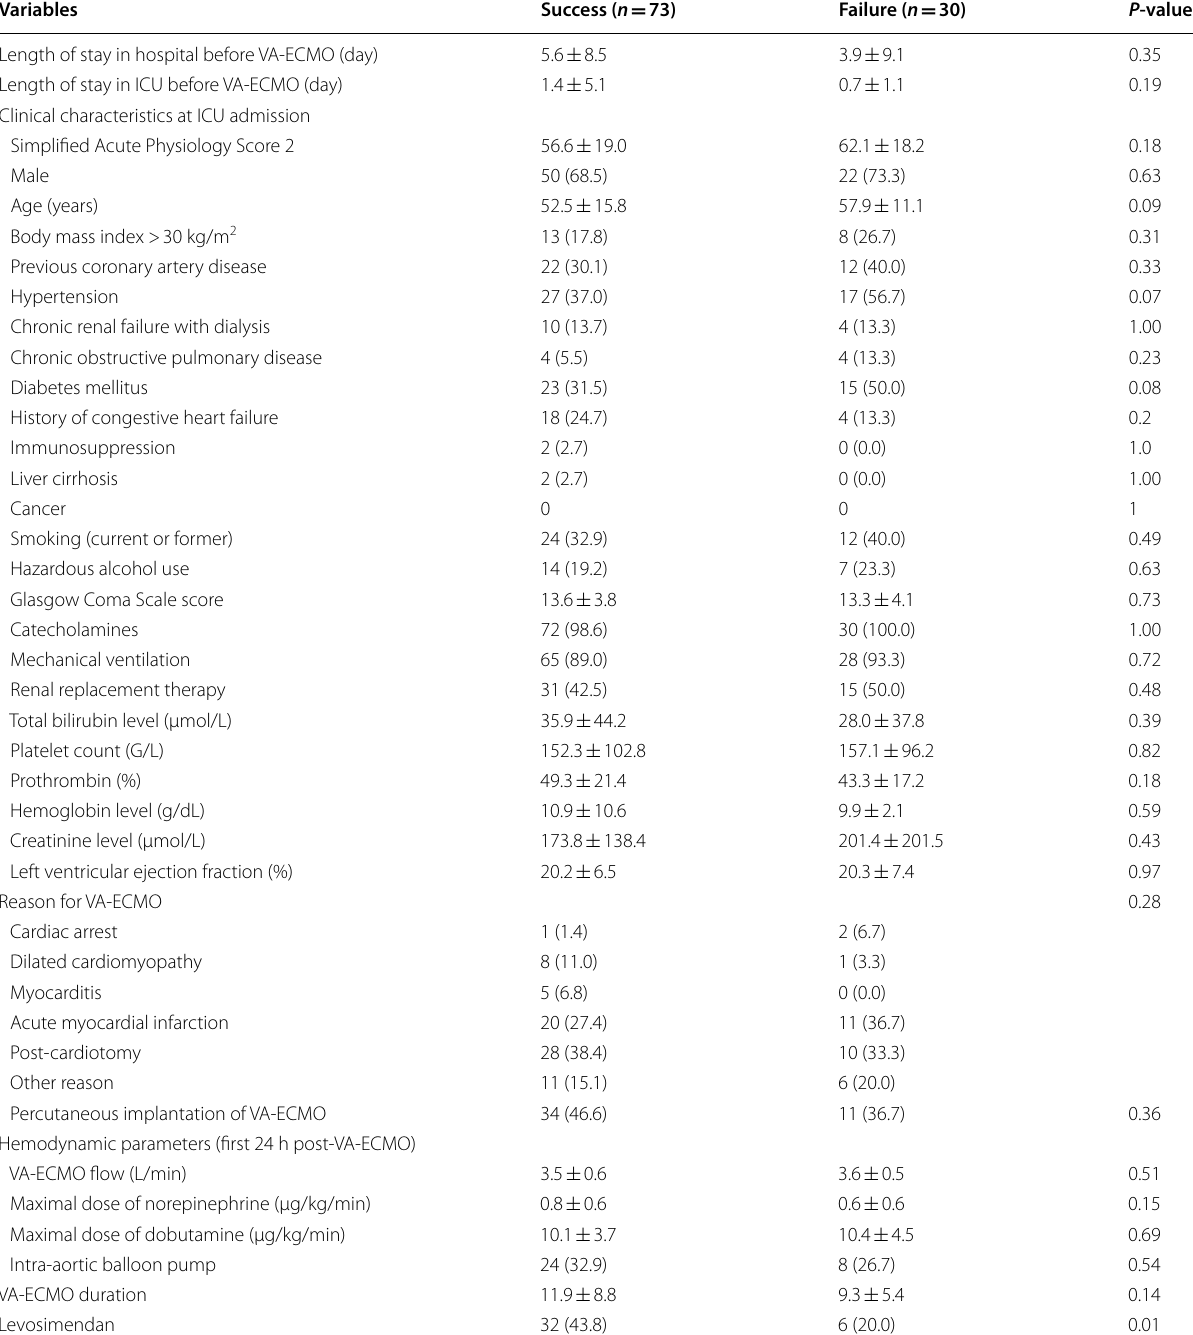
Table 3 Factors associated with VA-ECMO weaning after propensity score